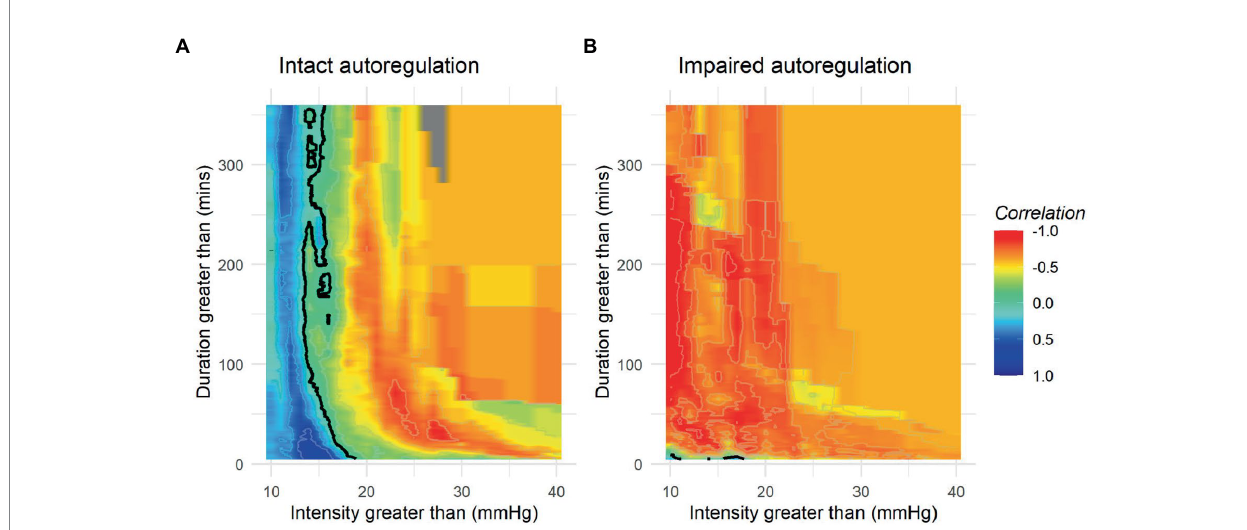
FIGURE 3 Population based incracranial pressure (ICP) intensity map stratified by autoregulatory status. Red areas indicate areas where ICP intensity is associated with poor outcome, while blue areas indicate good outcomes. Patients with intact autoregulation tolerate longer durations and intensities of ICP elevation compared to those with impaired autoregulation where no safe zone could be identified. (A) Intact autoregulation (mean PRx <= 0.3), (B) Impaired autoregulation (mean PRx > 0.3). Reprinted with permission from open access publication corresponding author, Akerlund and associates